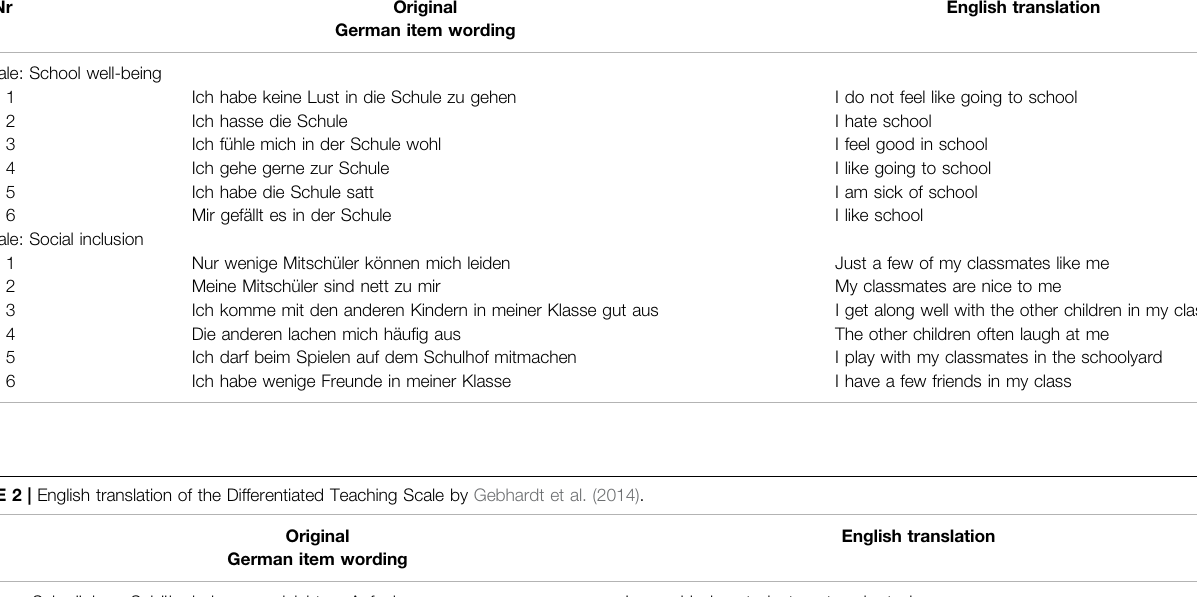
TABLE 1 | FEESS (Rauer and Schuck, 2003): items selected for the current study. Item Nr